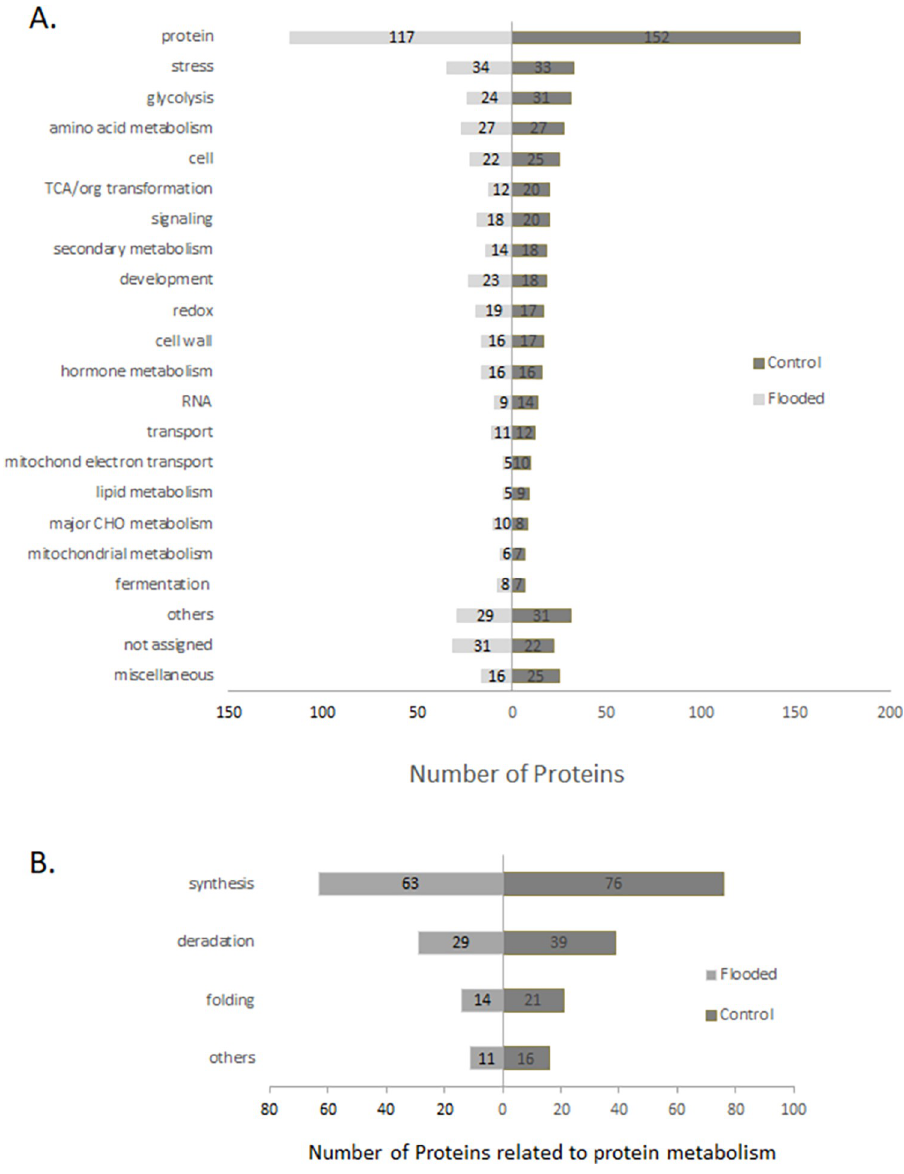
Fig 3. MapMan-based functional categorization of proteins identified in soybean roots exposed to flooding stress. A. All categories; B. Sub-categories of protein metabolism-related proteins. protein L16p/L10e family protein (Glyma14g36620.1), alcohol dehydrogenase 1 (Gly- ma06g12780.1) and aldolase superfamily protein (Glyma02g38730.1). In cluster II, protein abundance was increased until 3 rd day of flooding 5(3), but decreased even than the starting point 2(0) on the next day. The proteins grouped in the 2 nd cluster included RmlC like cupins superfamily protein (Glyma03g32020.3 & Glyma11g15870.1), ribo- somal protein S13A (Glyma20g21370.1), sucrose synthase 4 (Glyma15g20180.1), formate dehydrogenase (Glyma19g01210.1), ribosomal protein L30/L7 family protein (Gly- ma08g23750.4), Pathogenesis-related thaumatin superfamily protein (Glyma12g06950.1), ure- ase accessory protein G (Glyma08g08970.1), uricase/urate oxidase/nodulin 35 putative